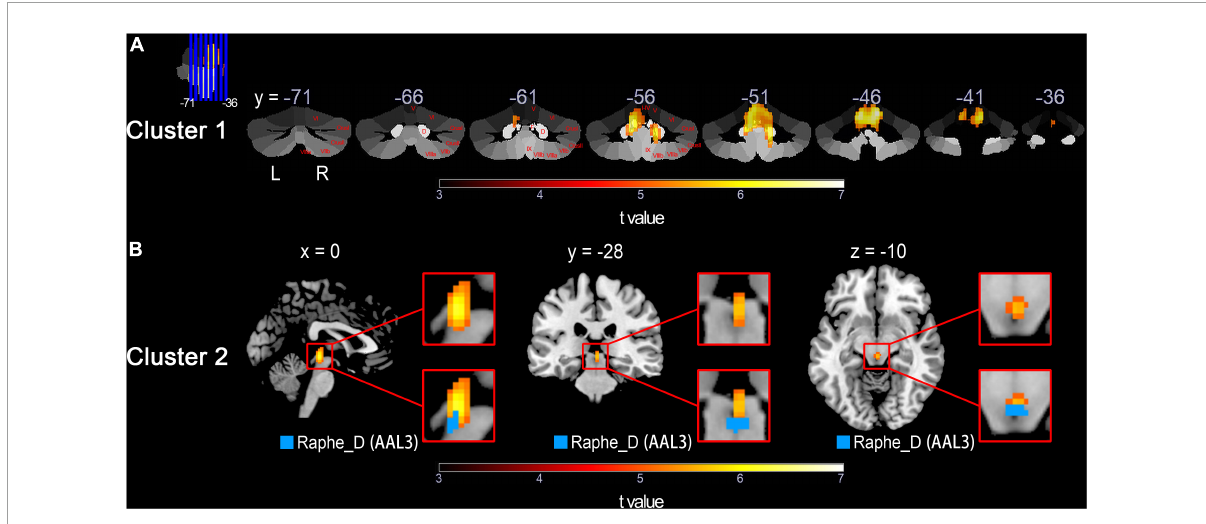
FIGURE1 Detailed visualization for voxel-based HC > SCD comparison across groups using normalized CBF values performed by the two-sample t -test with a threshold of P < 0.05 (FWE corrected) and cluster size of 10 voxels. The warm color represents voxels with significantly decreased CBF in the SCD group compared with the HC group. Results of the HC < SCD comparison are not shown because no significant voxel was detected under the same FWE correction threshold and cluster size. (A) Cluster 1 shown in yellow/red, overlaid onto the cerebellar atlas (Diedrichsen et al., 2009) in coronal slices. Cerebellar lobules and nucleus are marked in red on the right cerebellum. (B) Top row: magnified Cluster 2 shown in yellow/red; Bottom row: Cluster 2 with AAL3 brain region mapped on. HC, healthy control; SCD, spinocerebellar degeneration; CBF, cerebral blood flow; FWE, family-wise error; Roman numerals I-X, number of cerebellar hemisphere lobules (Schmahmann et al., 1999); D, dentate nucleus; F, fastigial nucleus; Raphe_D, dorsal raphe nucleus (Rolls et al., 2020); L, left; R, right; x,y,z, space coordinates.